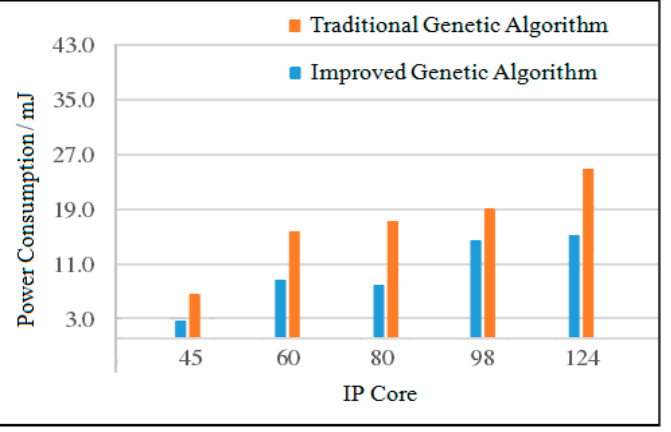
Figure 18. Comparison of the minimum power consumption of the two algorithms.